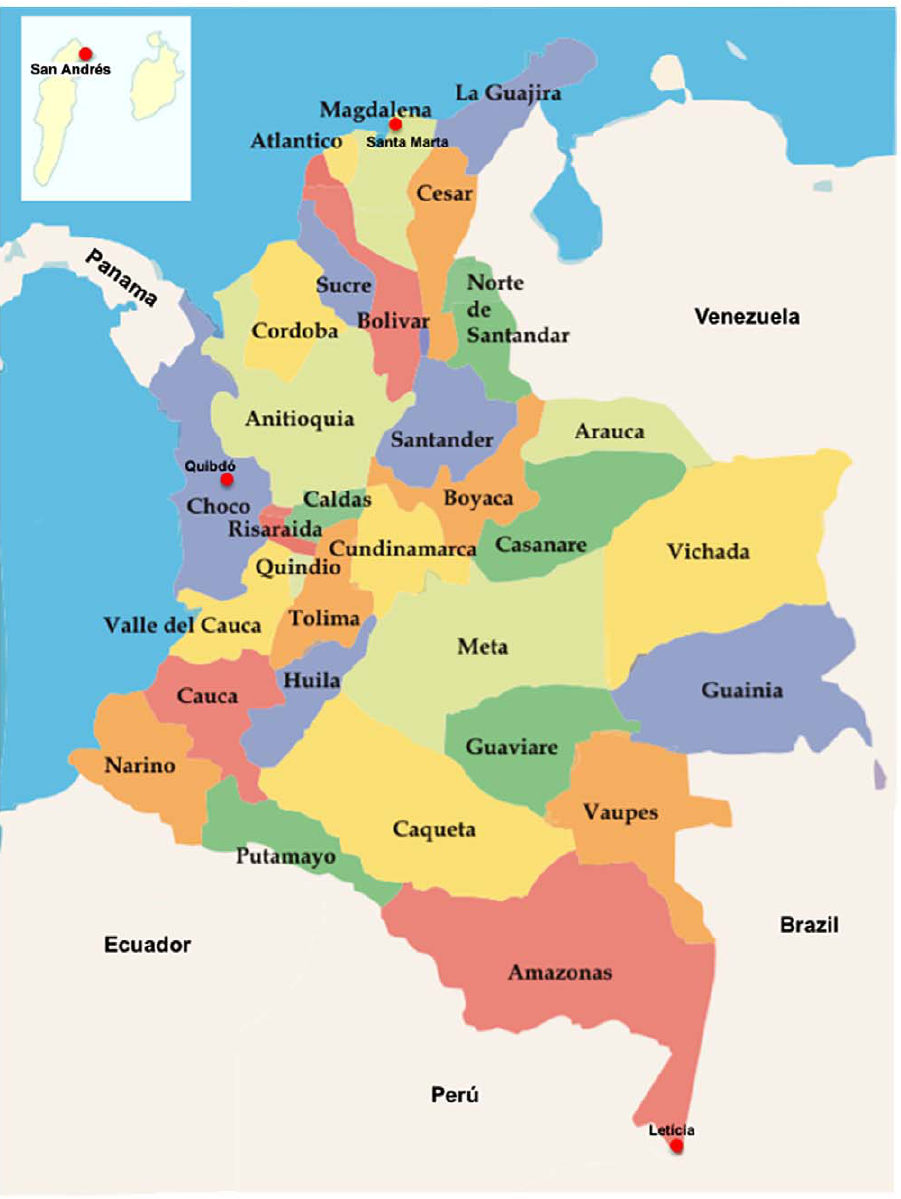
Figure 1. Geographic localization of the four places from where samples were collected in Colombia. The capital of each department is N ). in red (